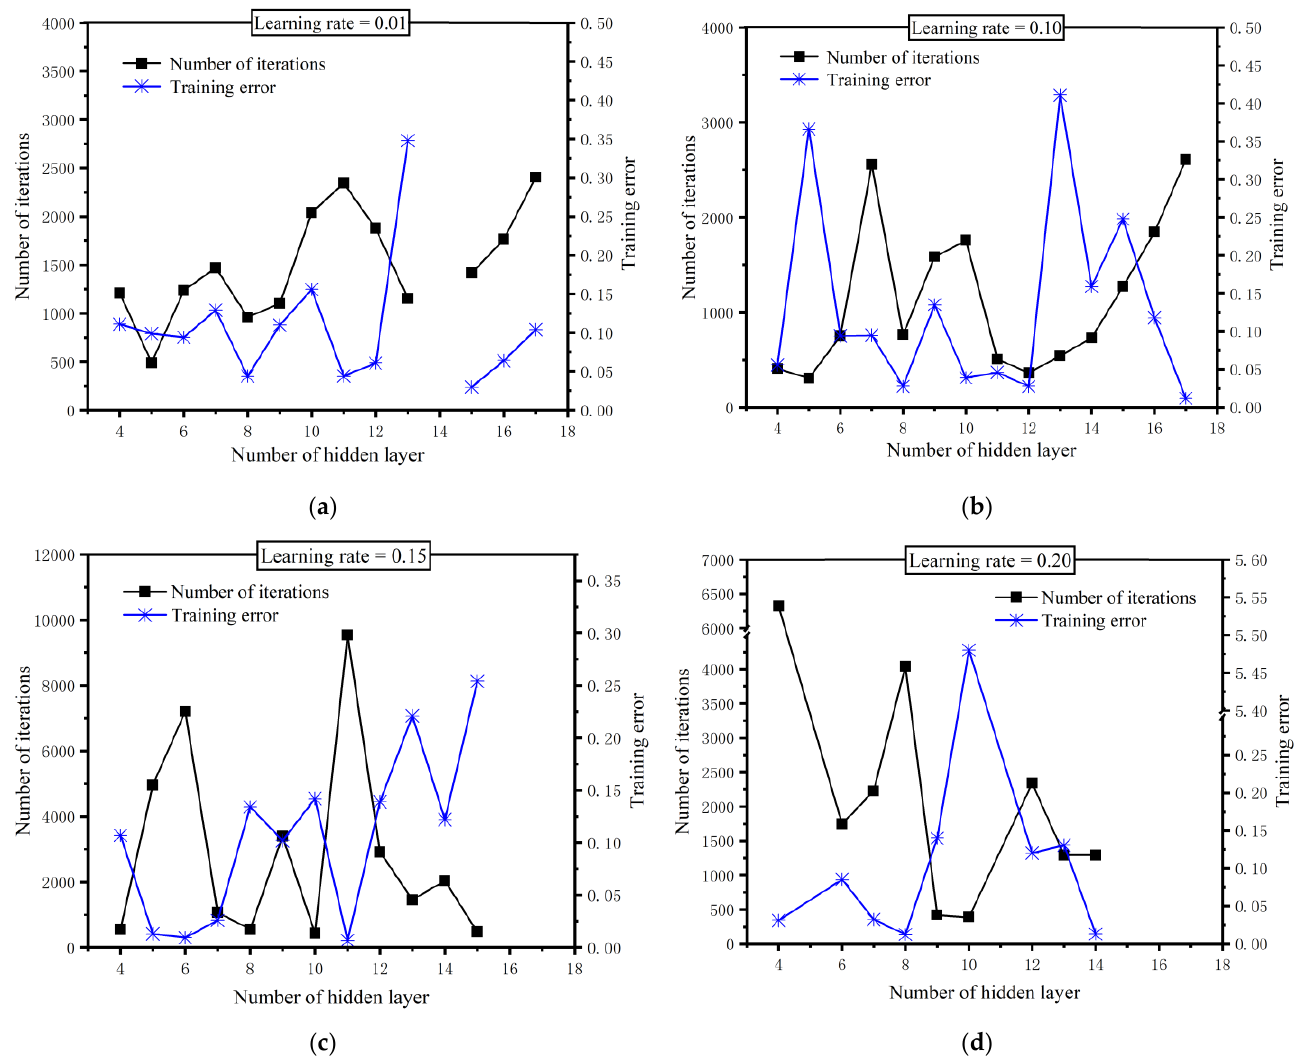
Figure 5. Performance comparison with different hidden layers: ( a ) indicates the situation where the learning rate is 0.01; ( b ) indicates the situation where the learning rate is 0.10; ( c ) indicates the situation where the learning rate is 0.15; ( d ) indicates the situation where the learning rate is